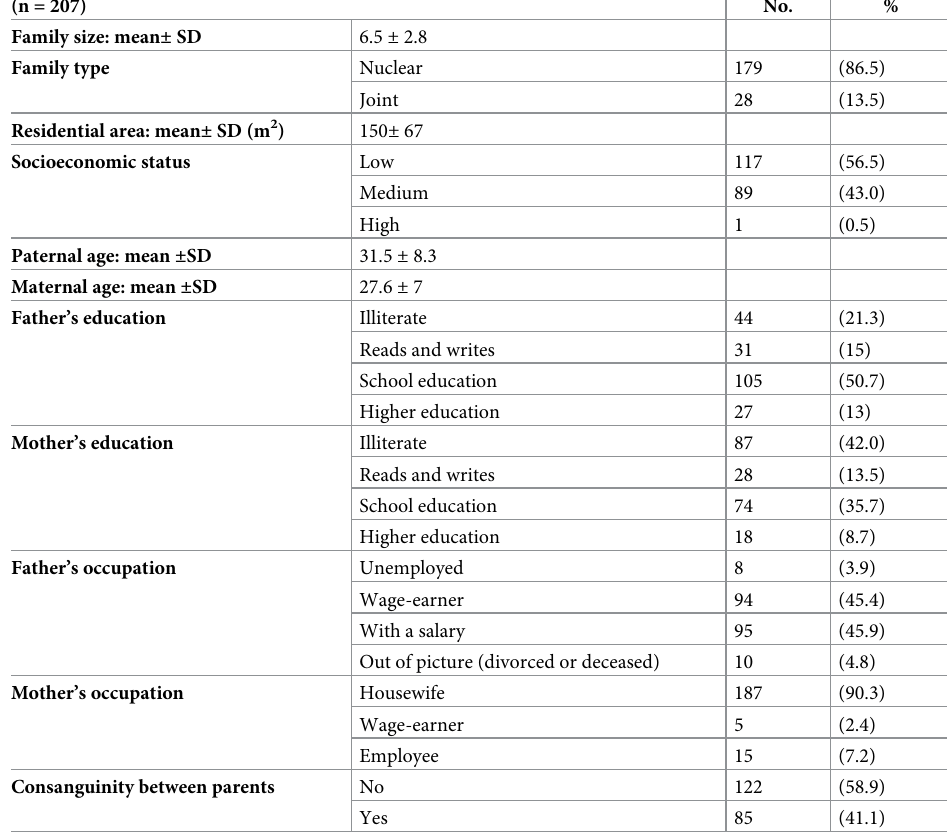
Table 2. Sociodemographic characteristics (family